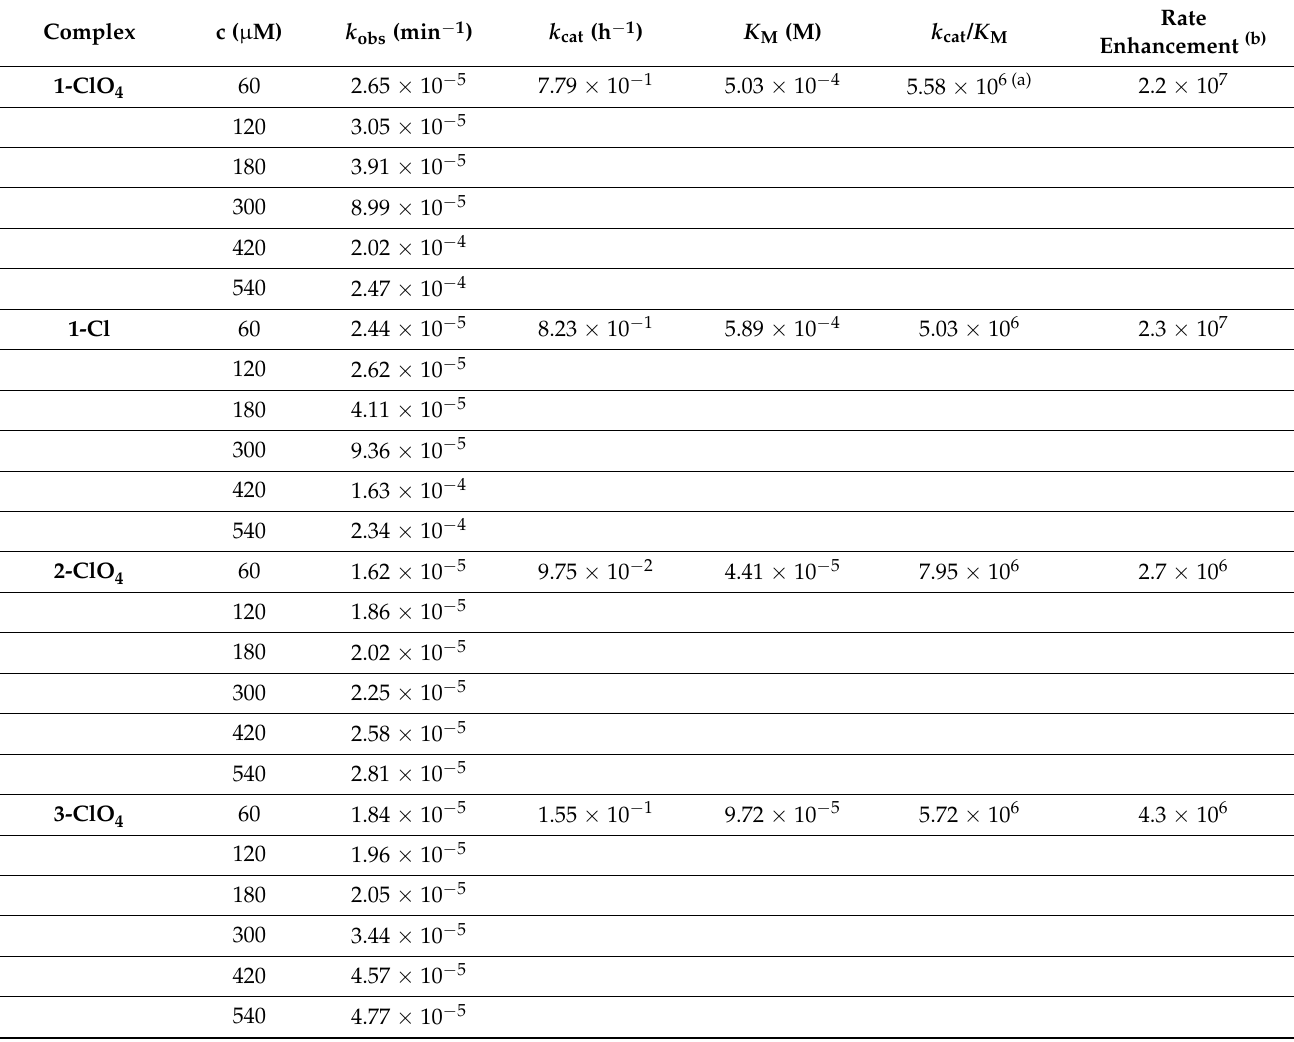
Table 2. Pseudo-first-order Michaelis–Menten kinetic data for the cleavage of pBR322 plasmid DNA (0.025 µ g/ µ L) by the complexes 1-ClO 4 – 3-ClO 4 and 1-Cl at 37 ◦ C and pH